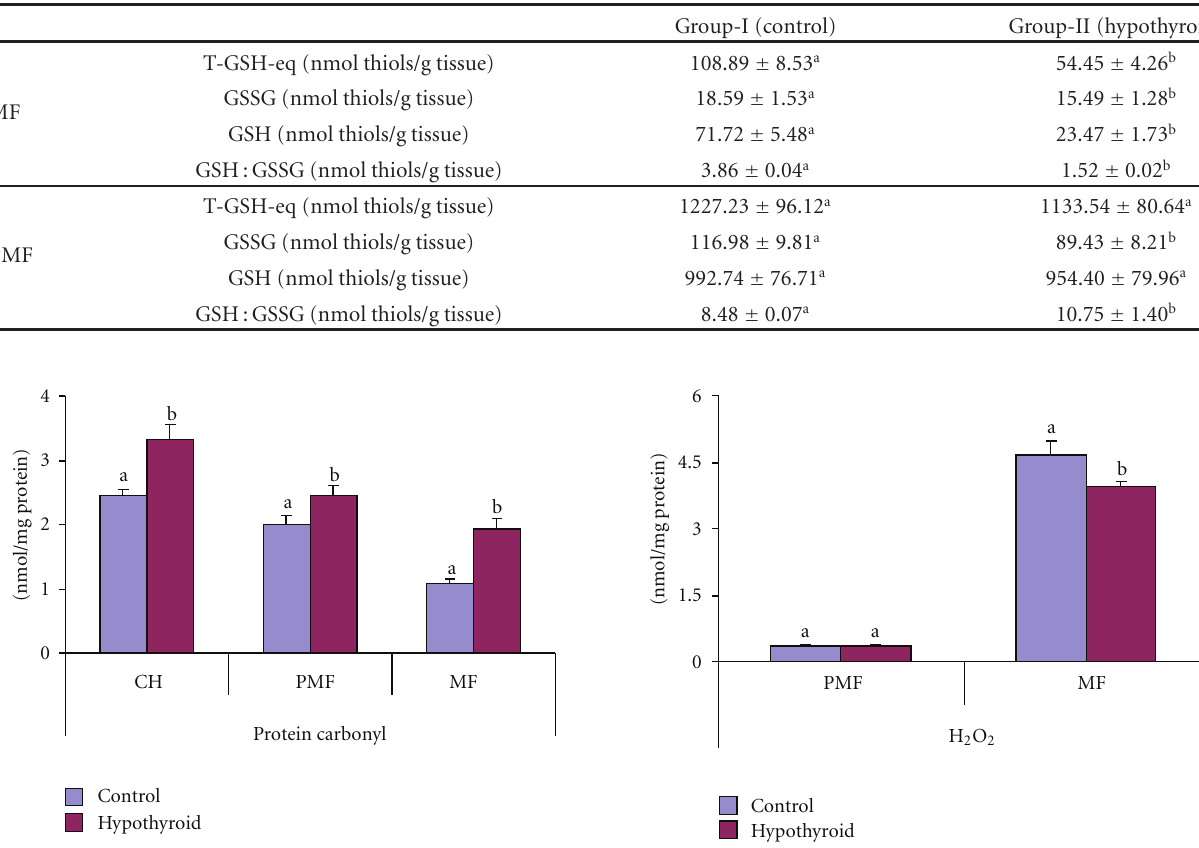
Figure 2: E ff ect of neonatal PTU treatment on protein carbonyl content (nmol/mg protein) in crude homogenate (CH), postmi- tochondrial fraction (PMF), and mitochondrial fraction (MF) of testes of rats. Data are expressed as mean ± S.D. of 5 observations and subjected to unpaired Student’s t -test. Statistical significance was accepted at P < 0 . 05. Control and hypothyroid groups were found to di ff er significantly at P < 0 . 05 as represented by super- scripts of di ff erent letters. Control (Group-I): 30-day-old control rats; hypothyroid (Group-II): 30-day-old rats with PTU treatment from day 1 postpartum to day 30 postpartum.